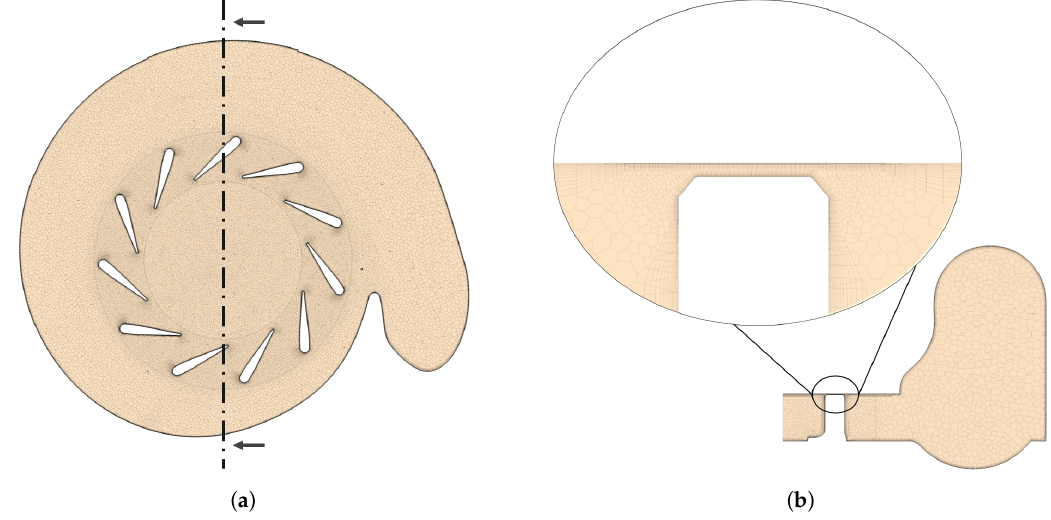
Figure 5. Final mesh: ( a ) overview; ( b ) side view with tip mesh detail.